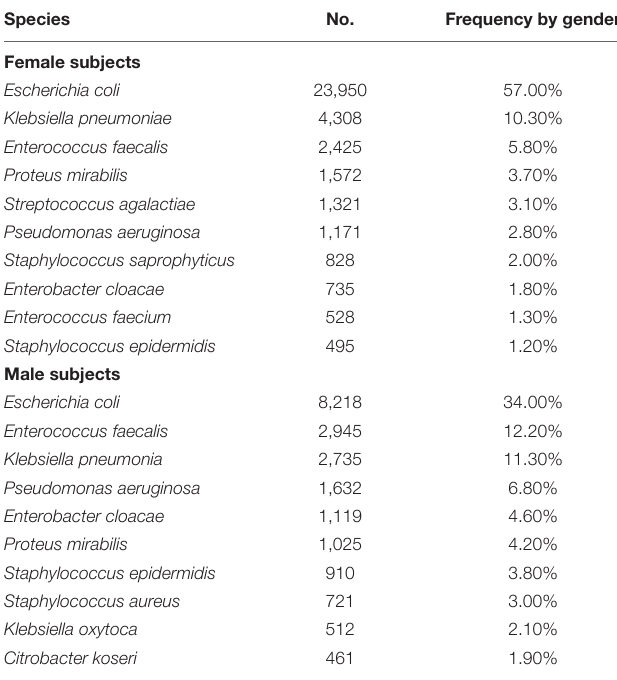
Extracted data extracted specimens collected from February 10, 2014 to June 8, 2019. A total of 75,707 bacterial identifications were performed, accounting for 66,141 positive samples. Data were de-replicated per both hospitalization stay and